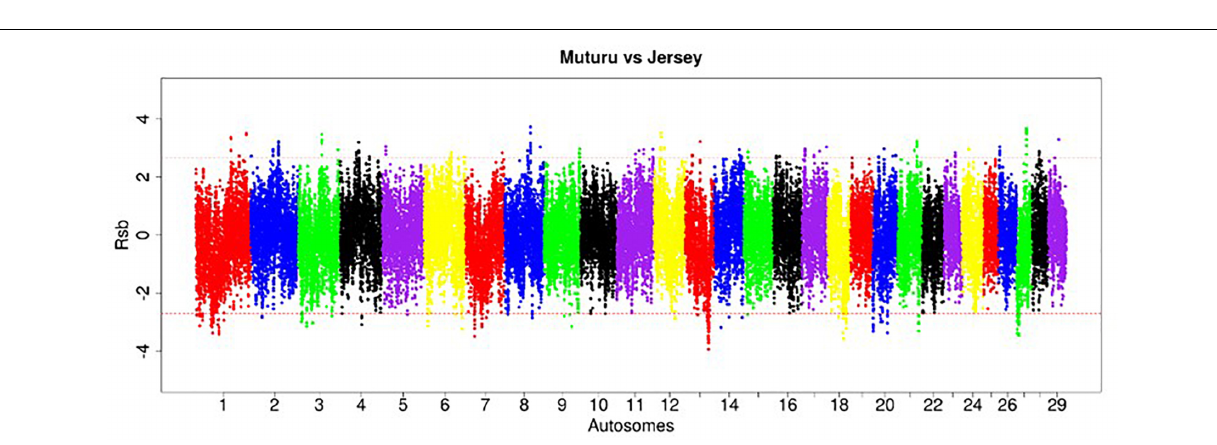
FIGURE 6 | Manhattan plot of the genome-wide distribution of Rsb Muturu – Holstein. Red dash lines are the thresholds of the windows in the top 0.5% Rsb scores.